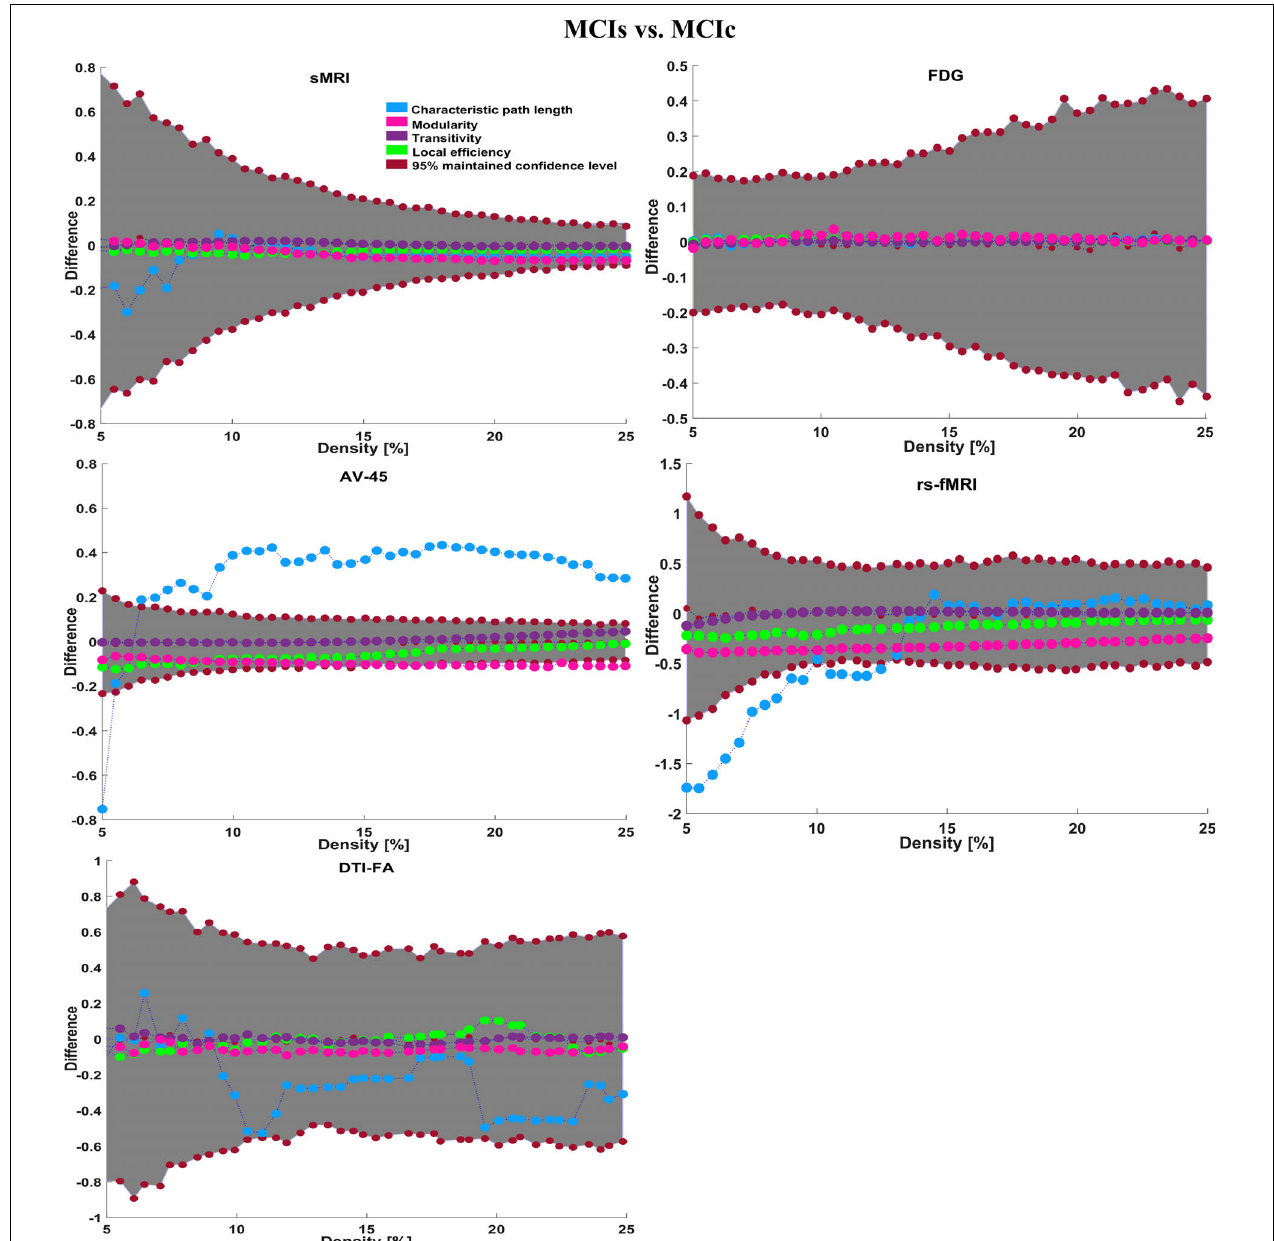
FIGURE 13 | Differences between the MCIs vs. MCIc group and global structural topology. The blue sphere represents characteristic path length, green sphere represents local efficiency, pink sphere represents modularity, purple sphere represents transitivity, and the dark red sphere represents 95% confidence intervals for these